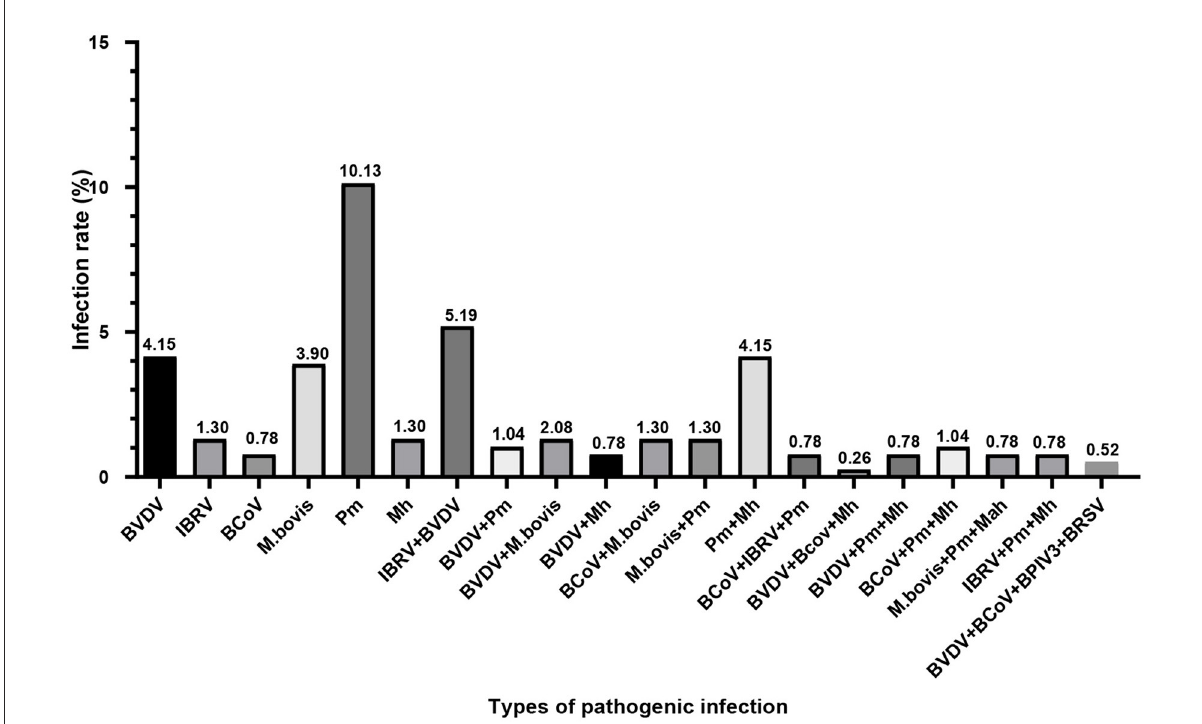
FIGURE6 Pathogens of respiratory diseases in nasal mucus samples from all clinical cattle were detected by PCR or RT-PCR. The ratio of each or combined pathogens was analyzed using Chi-square